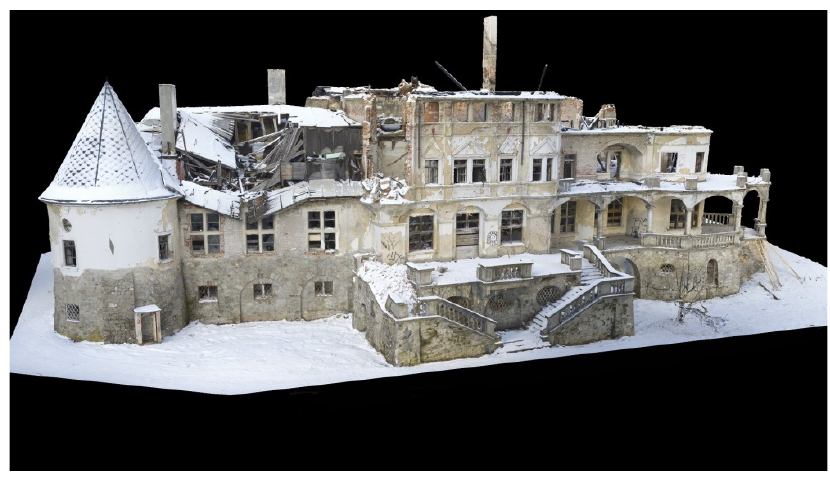
Figure 11. The Kunerad Castle model connected with terrestrial and aerial photogrammetry.